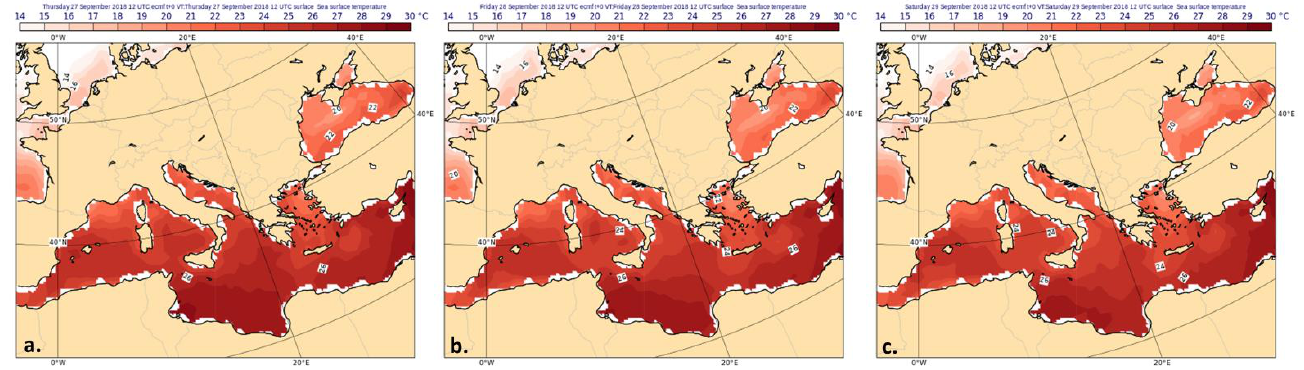
Figure 11. Sea surface temperature (SST; in ° C) for ( a ) 27/12 UTC, ( b ) 28/12 UTC, and ( c ) 29/12 UTC.